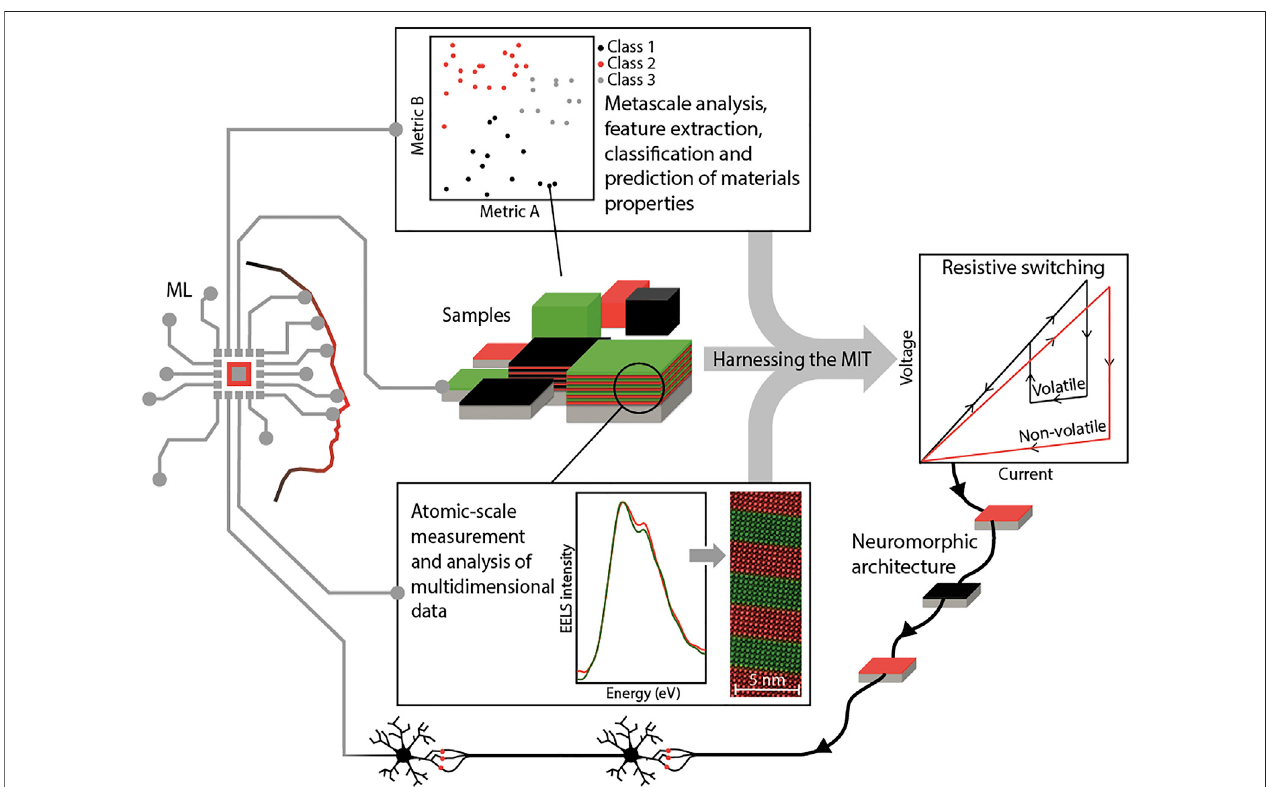
FIGURE1| Summaryofthein fl uenceofmachinelearningonatomicscaleandmetascaleanalysisofMITmaterials.TheEELspectraandSTEMimageareadaptedfrom reference 40. The clustering sketch shows that with a good choice of features (here called Metric A and Metric B) and enough data points extracted from fi rsthand results, correlationscanbeuncoveredprovidingnewunderstandingorguidingnewmaterialsdiscovery.Together,theMITcan bebetter-controlled and thesematerialscan provide new neuromorphiccomputingarchitectures usingresistiveswitching.These architecturesareinturnexpected tosigni fi cantly contributetodeep-learning applications.